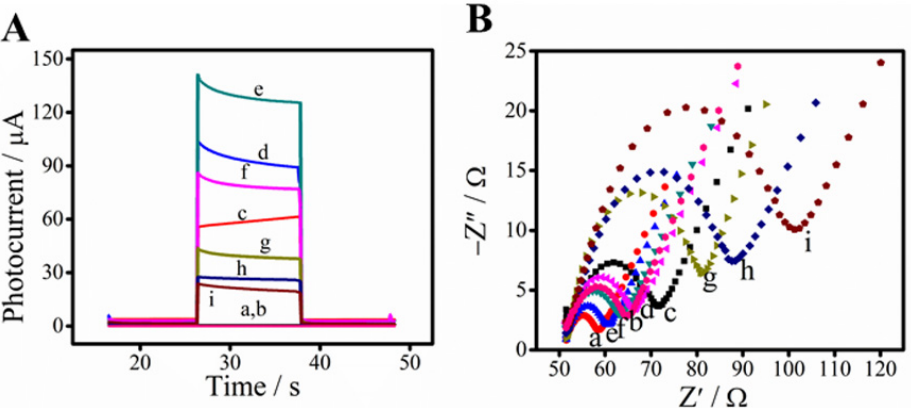
Figure 4. Photocurrent responses ( A ) and Nyquist plots of EIS ( B ). Different lines represent different materials to modify the electrode surface layer by layer: ITO electrode (a), after SnO 2 modified (b), after BiOI modified (c), after Ag 2 S deposited (d), after carboxylation of TGA (e), after drops of EDC/NHS (f), after anti-PCT immobilization (g), after BSA blocking (h), after incubation with 0.1 ng·mL − 1 of PCT (i).